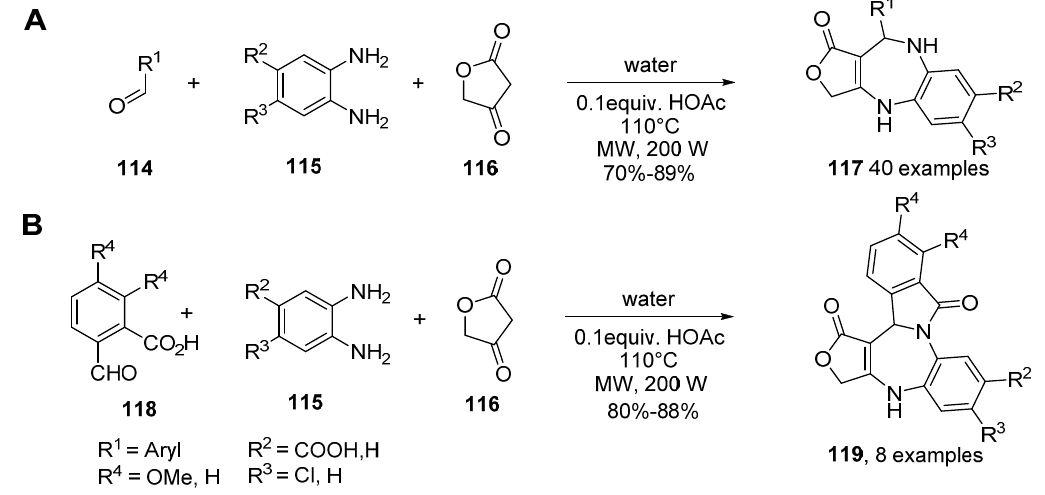
Scheme 20. Two step synthesis of benzodiazepinones via an Ugi 4-components reaction and intramolecular cyclization.